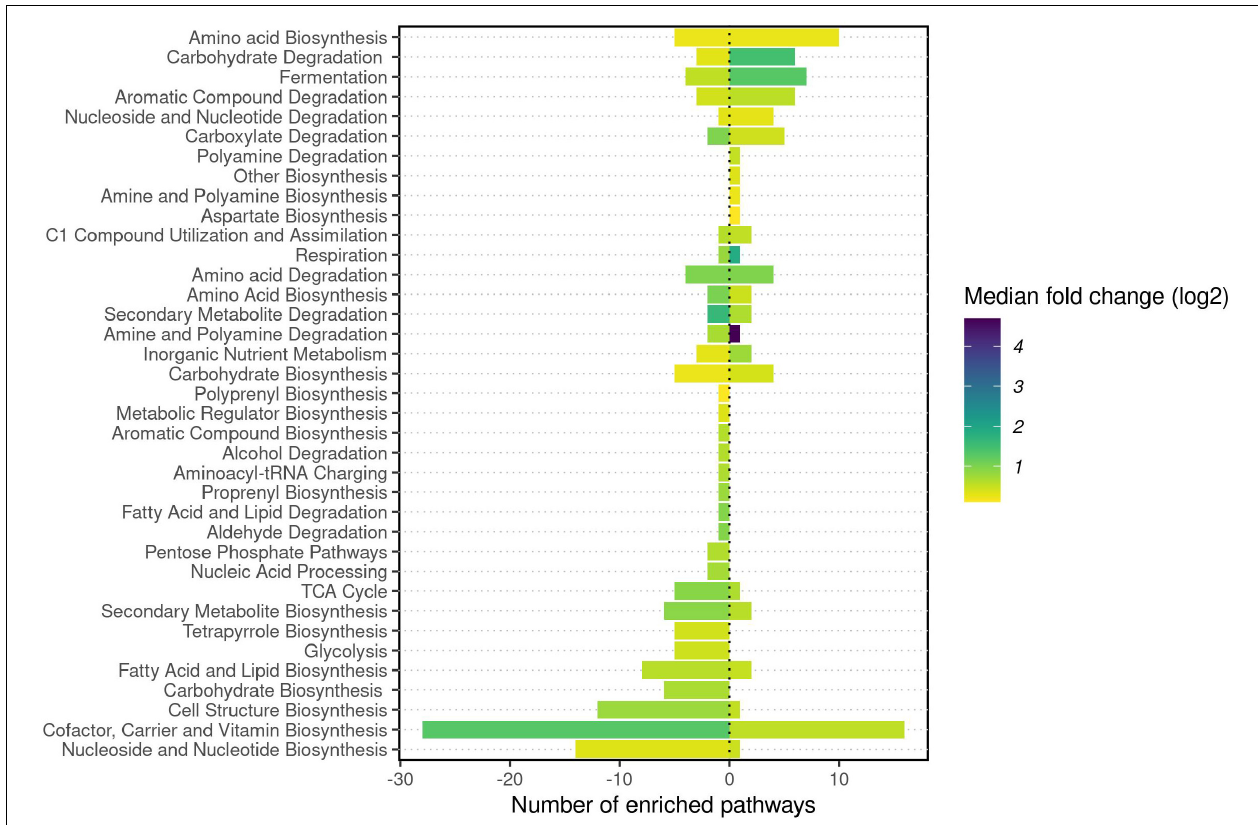
FIGURE 6 | DESeq2 analysis of inferred microbial functions from 16S rRNA gene data of six freshwater mussel species and the invasive clam Corbicula fluminea collected from six rivers in the Tennessee and Mobile River Basins. DESeq2 was used to determine which inferred pathways were significantly enriched in C. fluminea compared to native mussels, before the class of each pathway was recorded from the MetaCyc database and the number of pathways significantly enriched in each class was reported. Pathways enriched in C. fluminea are presented by positive values, while the negative values represent those enriched in mussels. For each host type and each class of pathway, the median of the log2 Fold change was used to color the